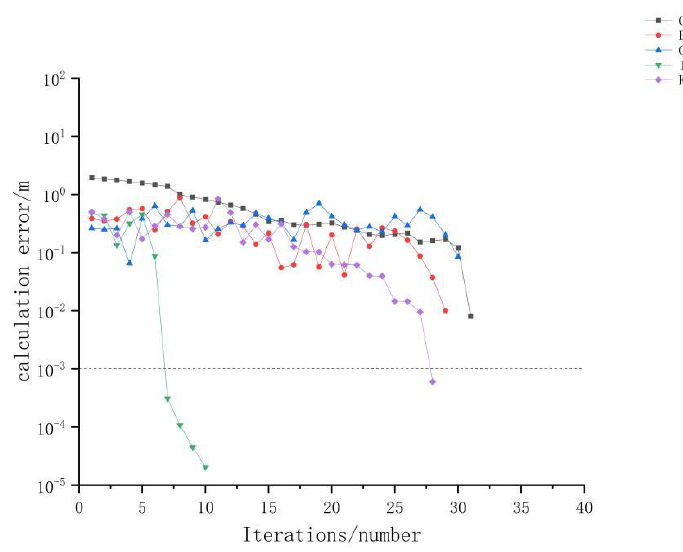
Figure 4. Calculation Results of Four-coordinate Calculation Model.